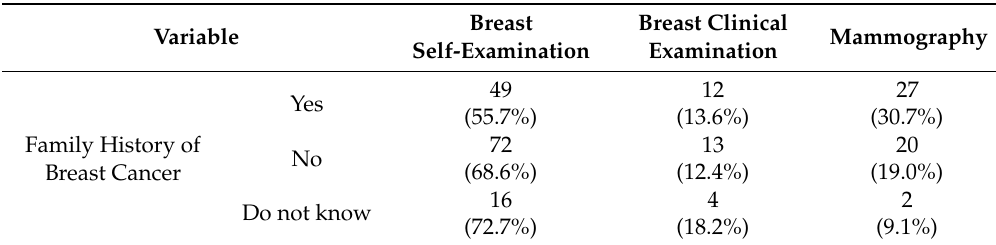
Table 2. Modes of detection of breast cancer suspected changes according to family history of breast cancer. Breast Self-